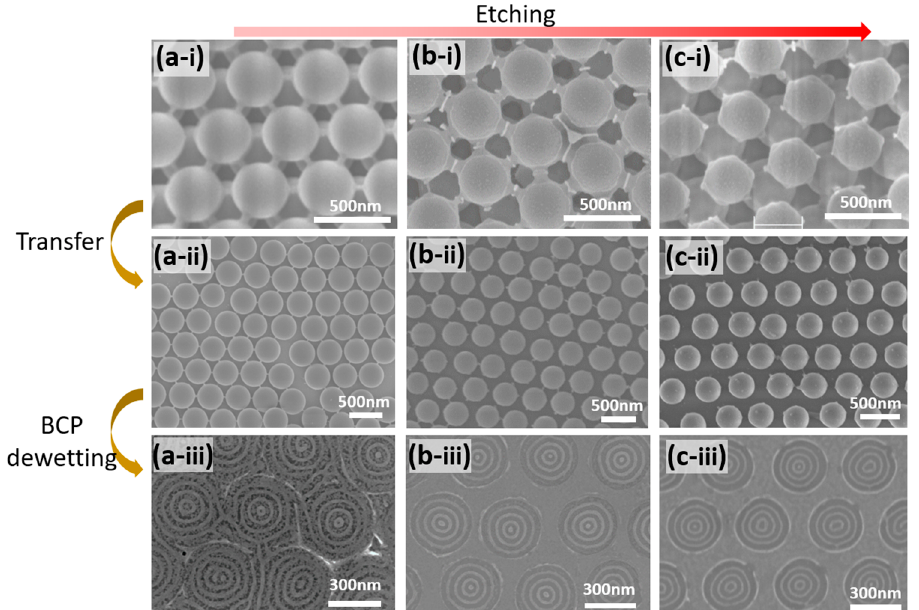
Figure 4. ( a-i – c-i ) Surface-etched multilayered colloidal crystals after O 2 plasma etching times of ( a-i ) 2 min, ( b-i ) 3 min, and ( c-i ) 4 min. ( a-ii – c-ii ) Respective non-close-packed hemispherical colloidal